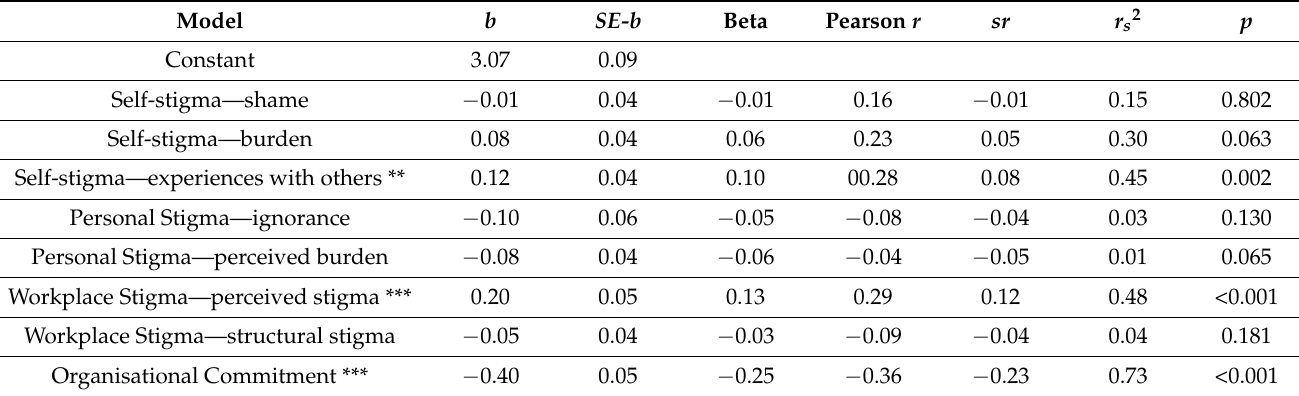
Table 3. Standard Multiple Regression Results for Self-stigma, Personal Stigma, and Workplace Stigma Predicting Police and Emergency Service Personnel’s Perceived Stress a Going Through the Claims Process for Psychological